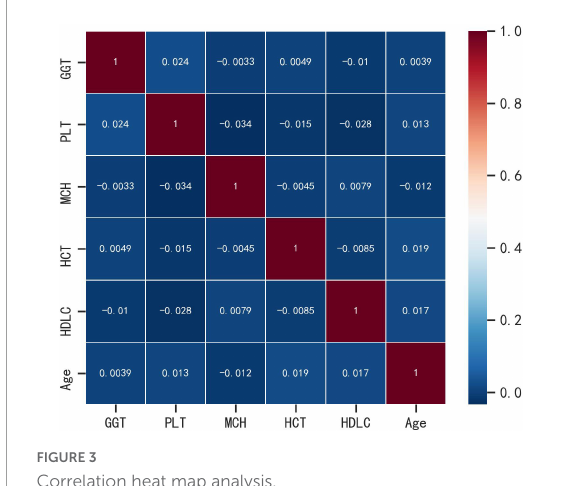
FIGURE3 Correlation heat map analysis.